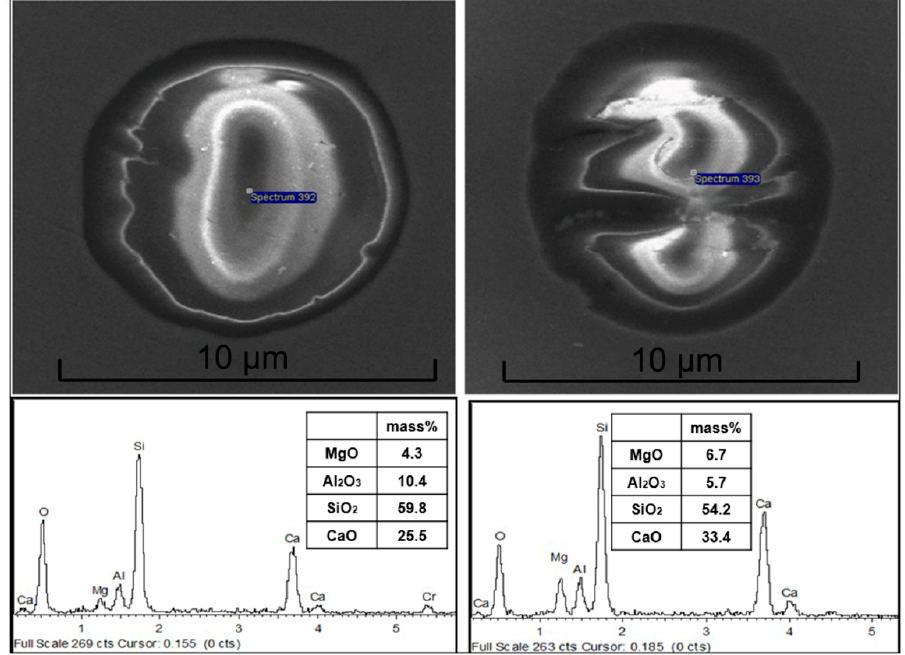
Figure 5. SEM images and EDS results of inclusions in the samples taken at AOD tapping when using ultra-purity FeSi alloy.